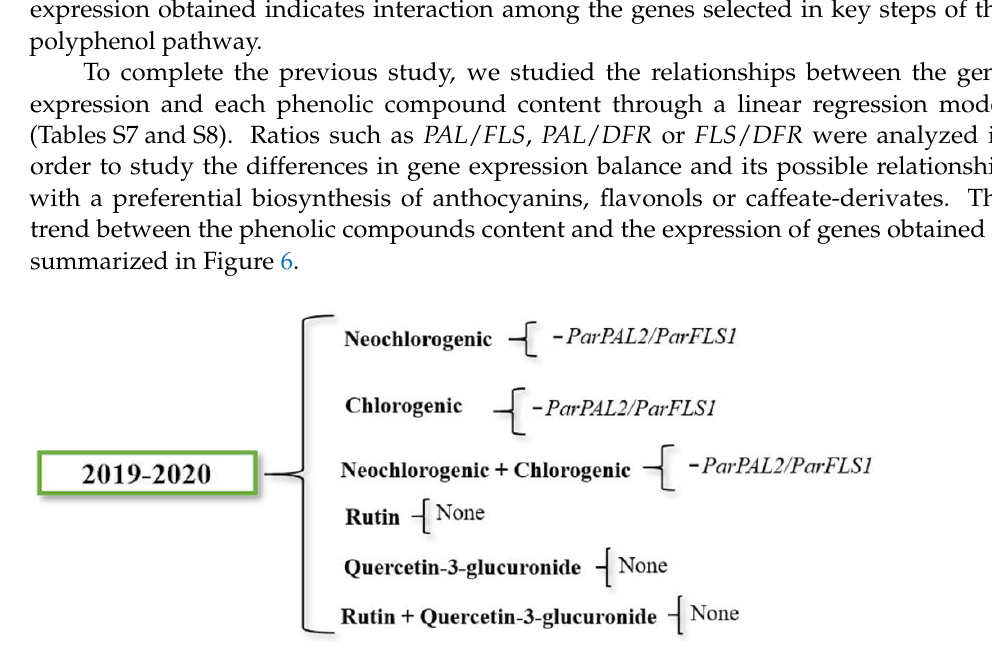
Figure 6. Significant effects of gene expression data from the linear regression model contributing to the content of each compound in both years studied. Negative symbol means negative contribu- tion.